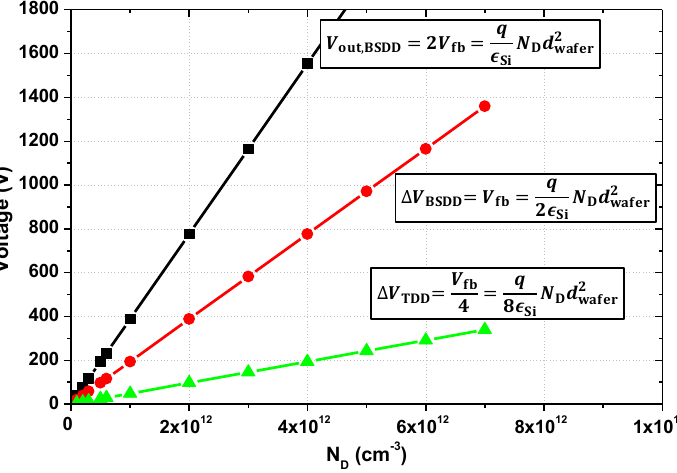
Figure 3. Analytically formulated maximum drift-field potential drops over BSDD and TDD structures and the corresponding applied voltages, versus the n-substrate doping.